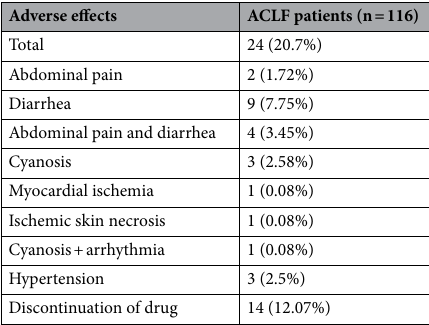
Table 2. Adverse effects related to terlipressin therapy. EASL European association for the study of the liver, ACLF acute-on-chronic liver failure.